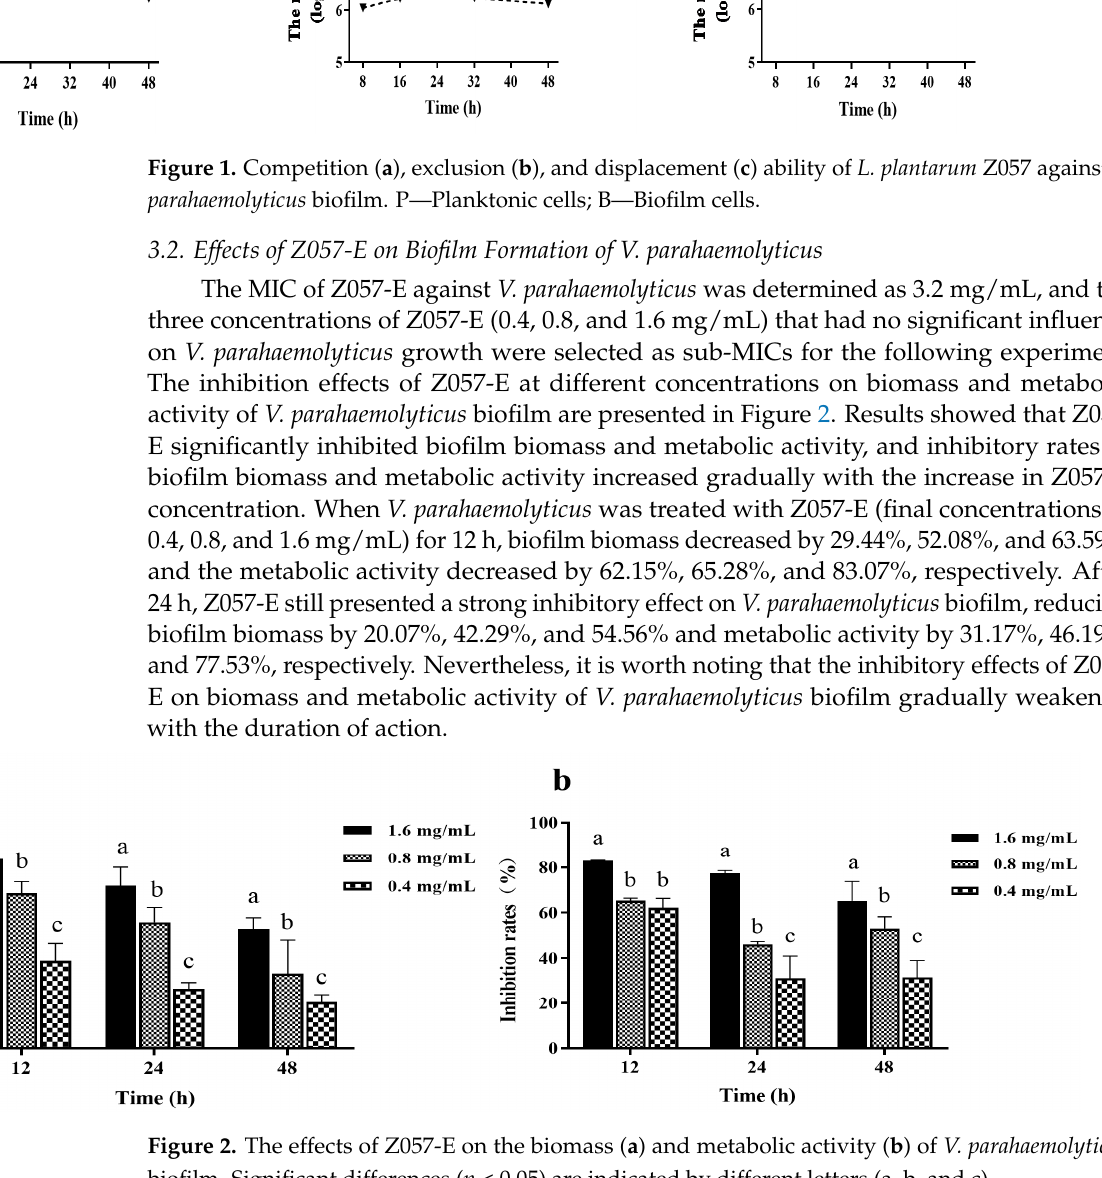
Figure 2. The effects of Z057-E on the biomass ( a ) and metabolic activity ( b ) of V. parahaemolyticus biofilm. Significant differences ( p < 0.05) are indicated by different letters (a, b, and c).